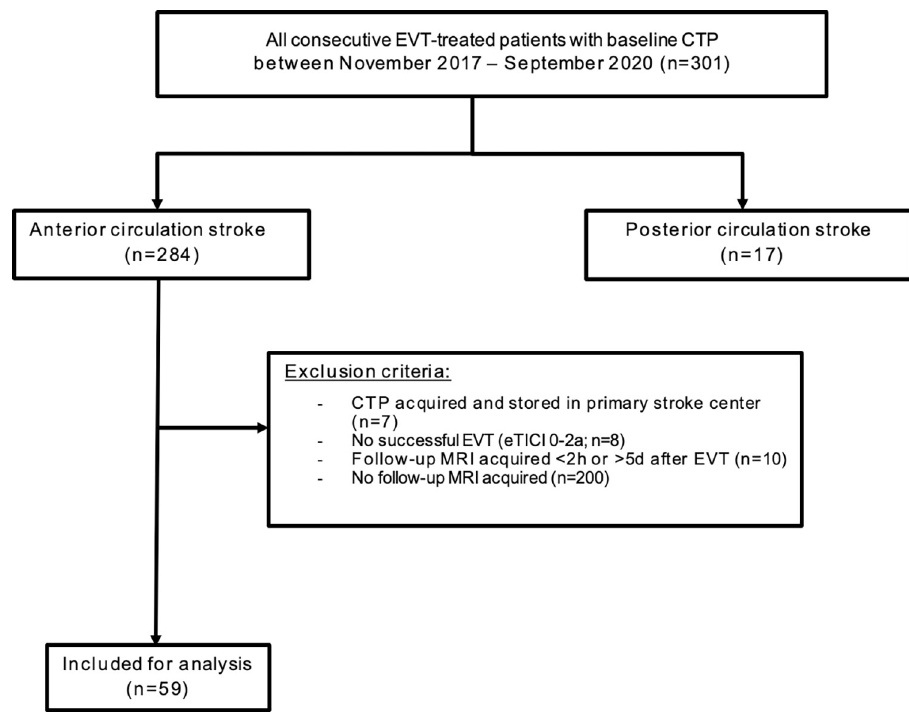
Fig 1. Flowchart of patient